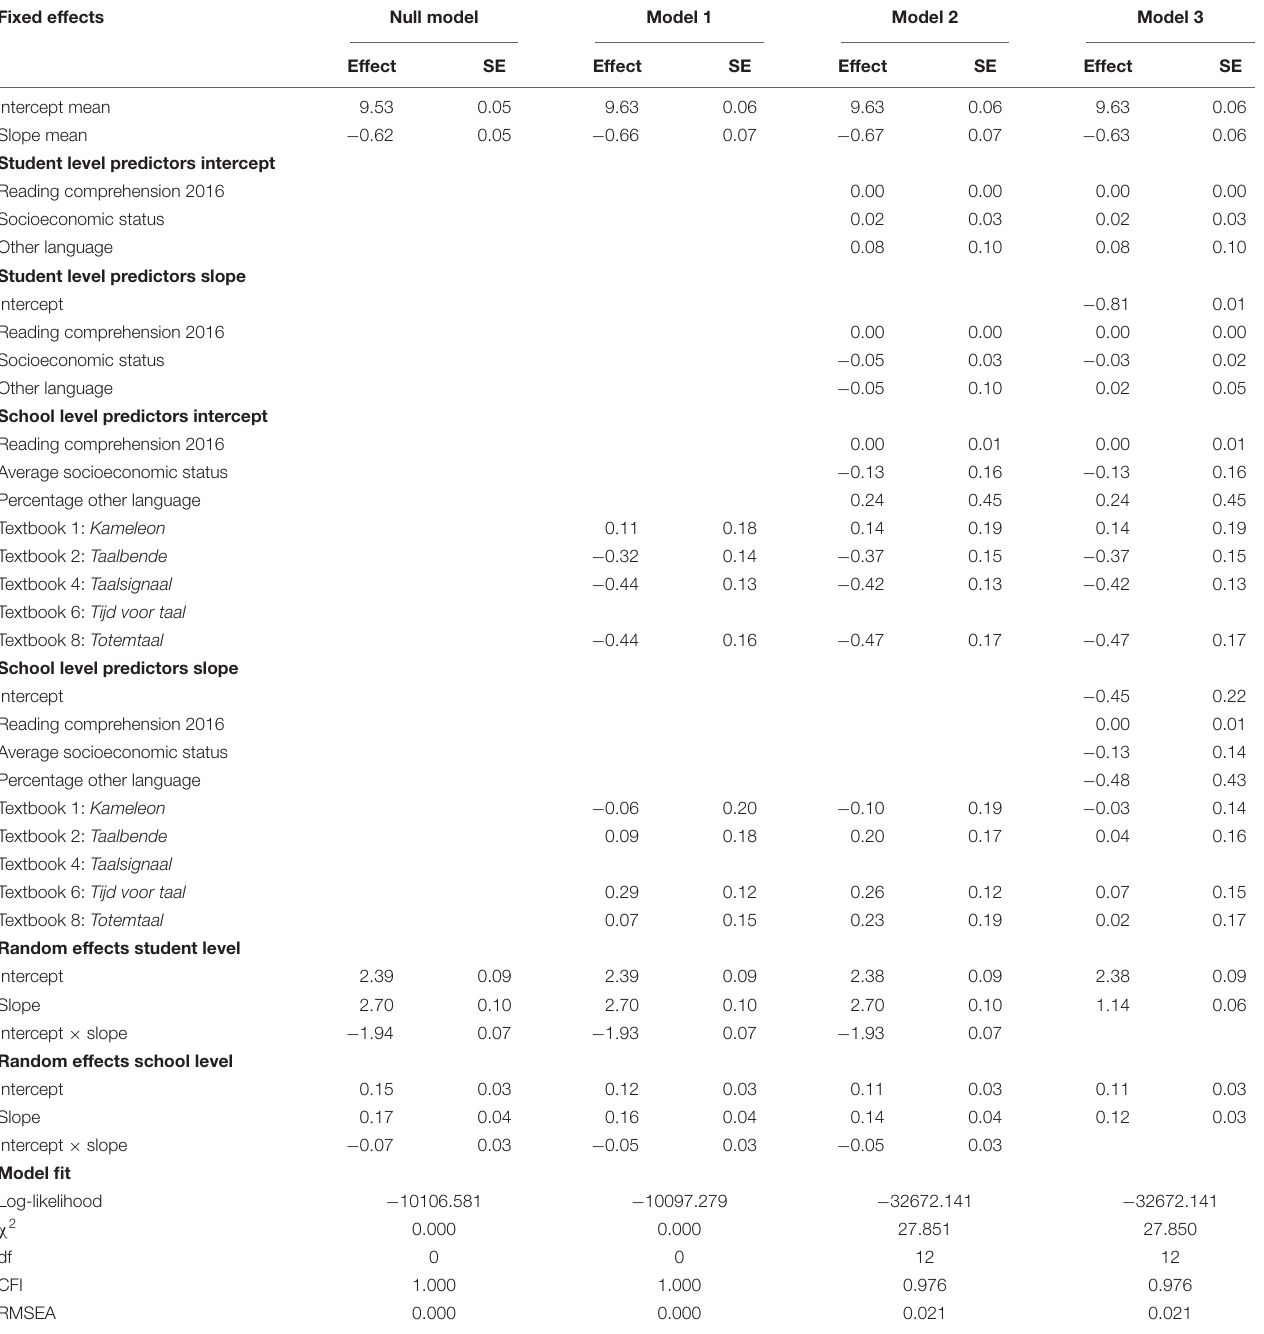
TABLE 7 | Coefficients multilevel change score model for reading